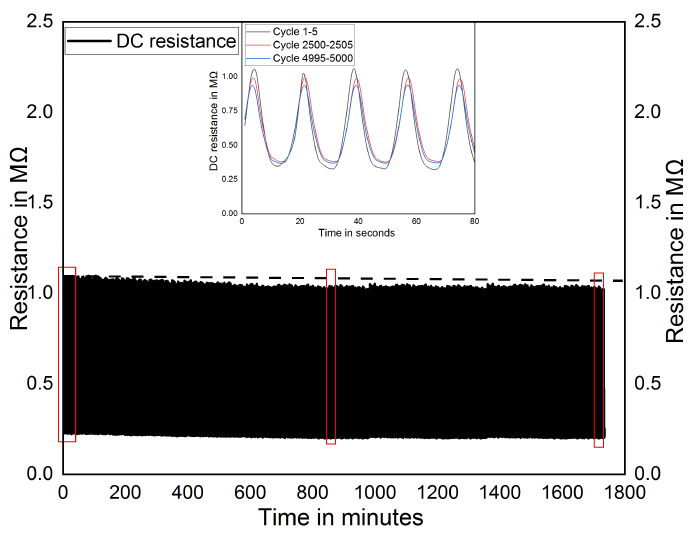
Figure 6. Cyclic response for 5000 cycles.